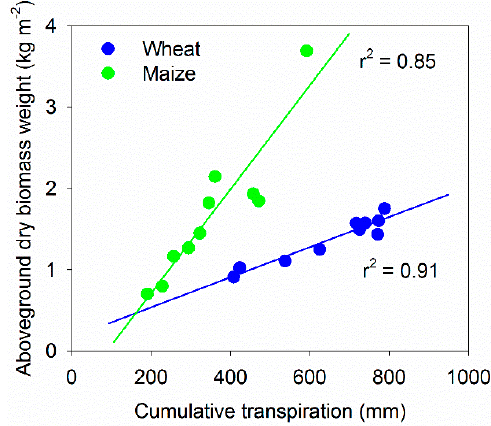
Figure 9. The relationship between the harvested aboveground dry biomass weight and cumulative transpiration for the growing period for wheat and maize per area in pots with covered soil surfaces. r 2 is the determination coefficient of the linear